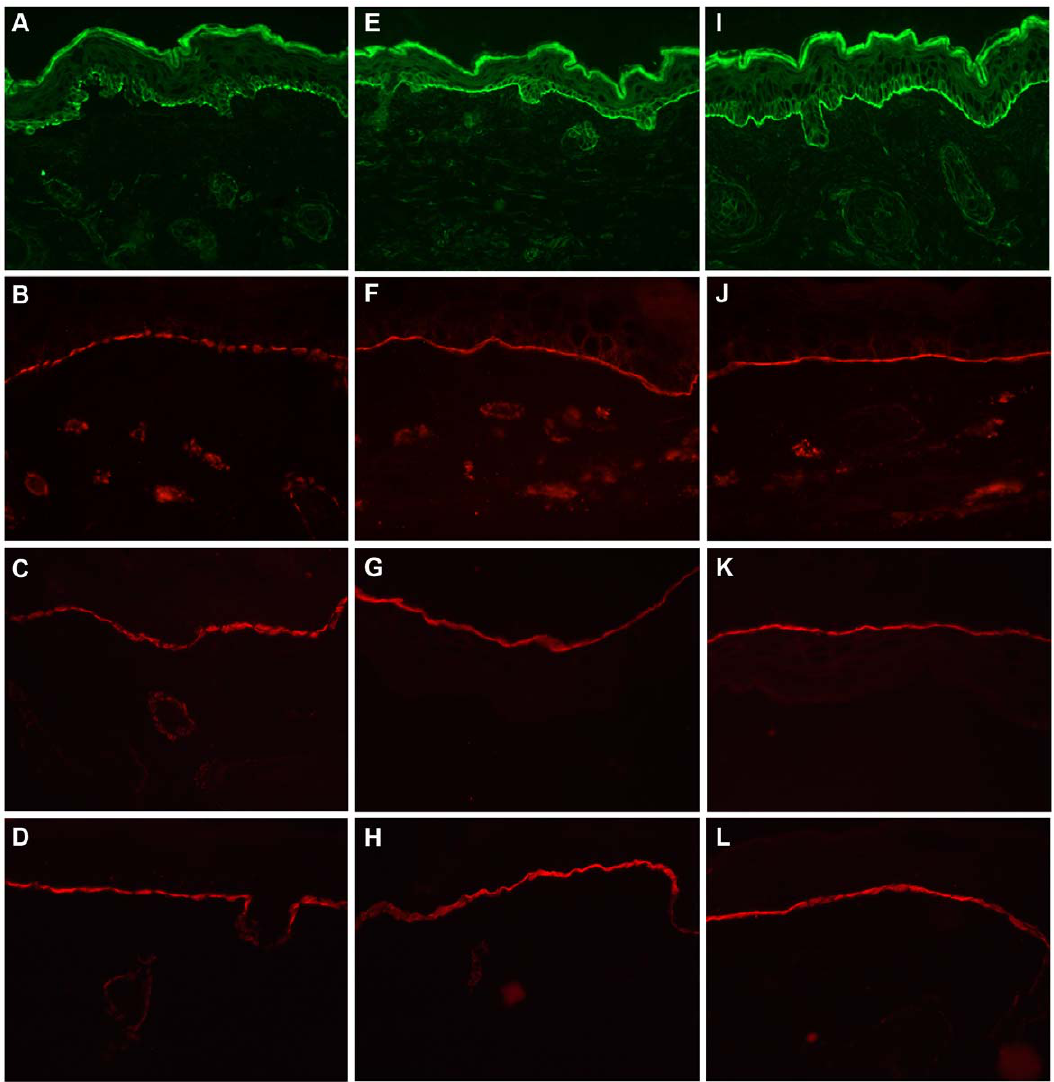
Figure 9. Localization of hemidesmosomal components is restored in rescued Lamc2 KO mice. Frozen skin sections of Lamc2 KO (A–D), rescued Lamc2 KO (E–H), and Lamc2 WT (I–L) newborn mice were immunostained for skin hemidesmosomal components plectin (A, E, I), BP180/Col XVII (B, F, J), and integrin chains a 6 (C, G, K) and ß4 (D, H, L). The immunostaining pattern for all hemidesmosomal proteins in the Lamc2 KO mice appeared discontinuous, whereas the staining patterns in rescued Lamc2 KO and Lamc2 WT mice appeared more